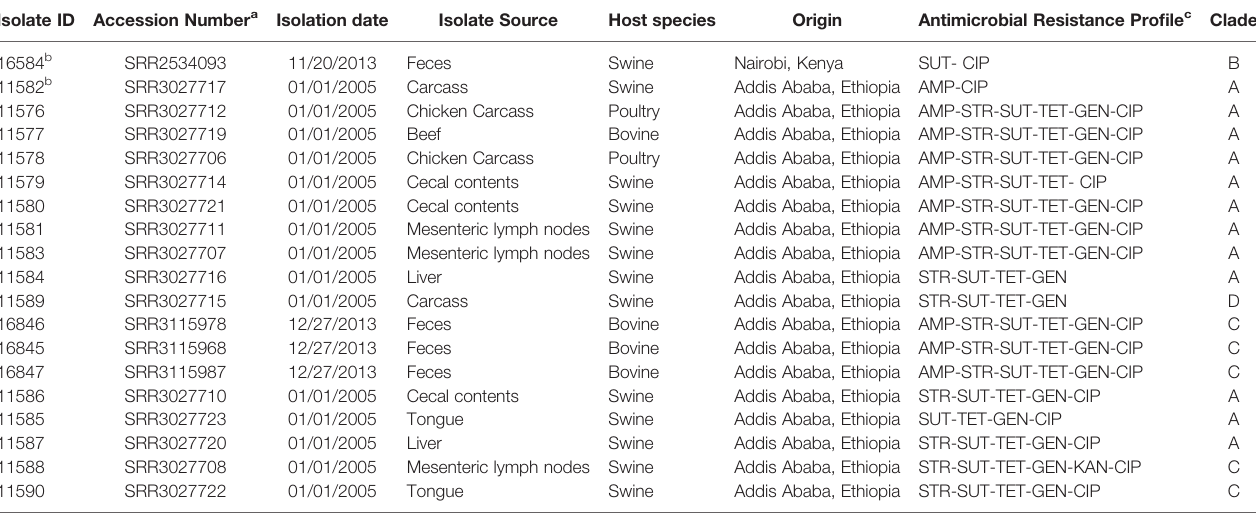
TABLE 1 | Salmonella enterica serovar Kentucky ST198 isolates (n=19) cultured from animal sources in Ethiopia and